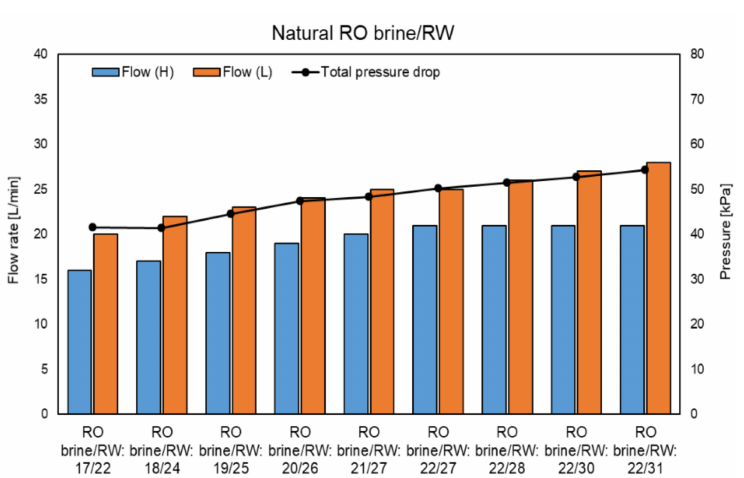
Figure A9. Pressure drops of RED stack as a function of the feed flow rate using the natural RO brine/RW.